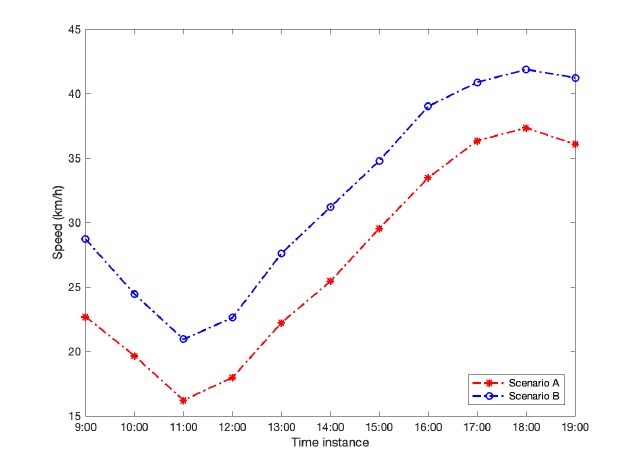
Figure 4. Mobility between 9 a.m. 7 p.m. (data collected